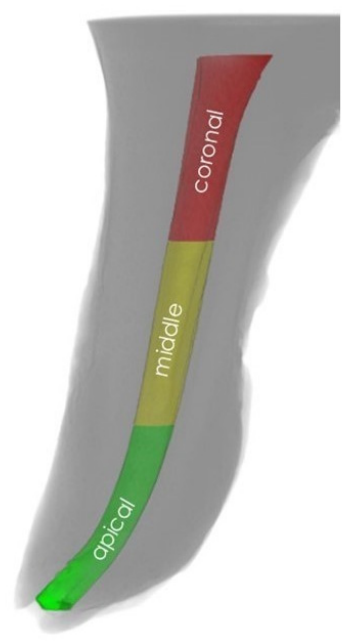
Figure 2. Volume of interest divided into three